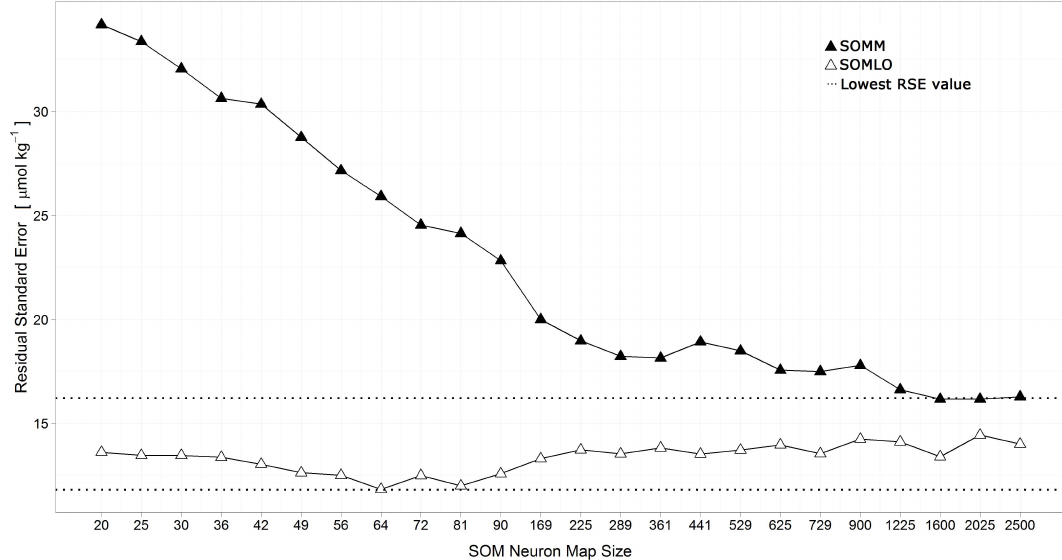
Fig. 10. Skill comparison between the SOMLO and SOMM models in capturing C T .